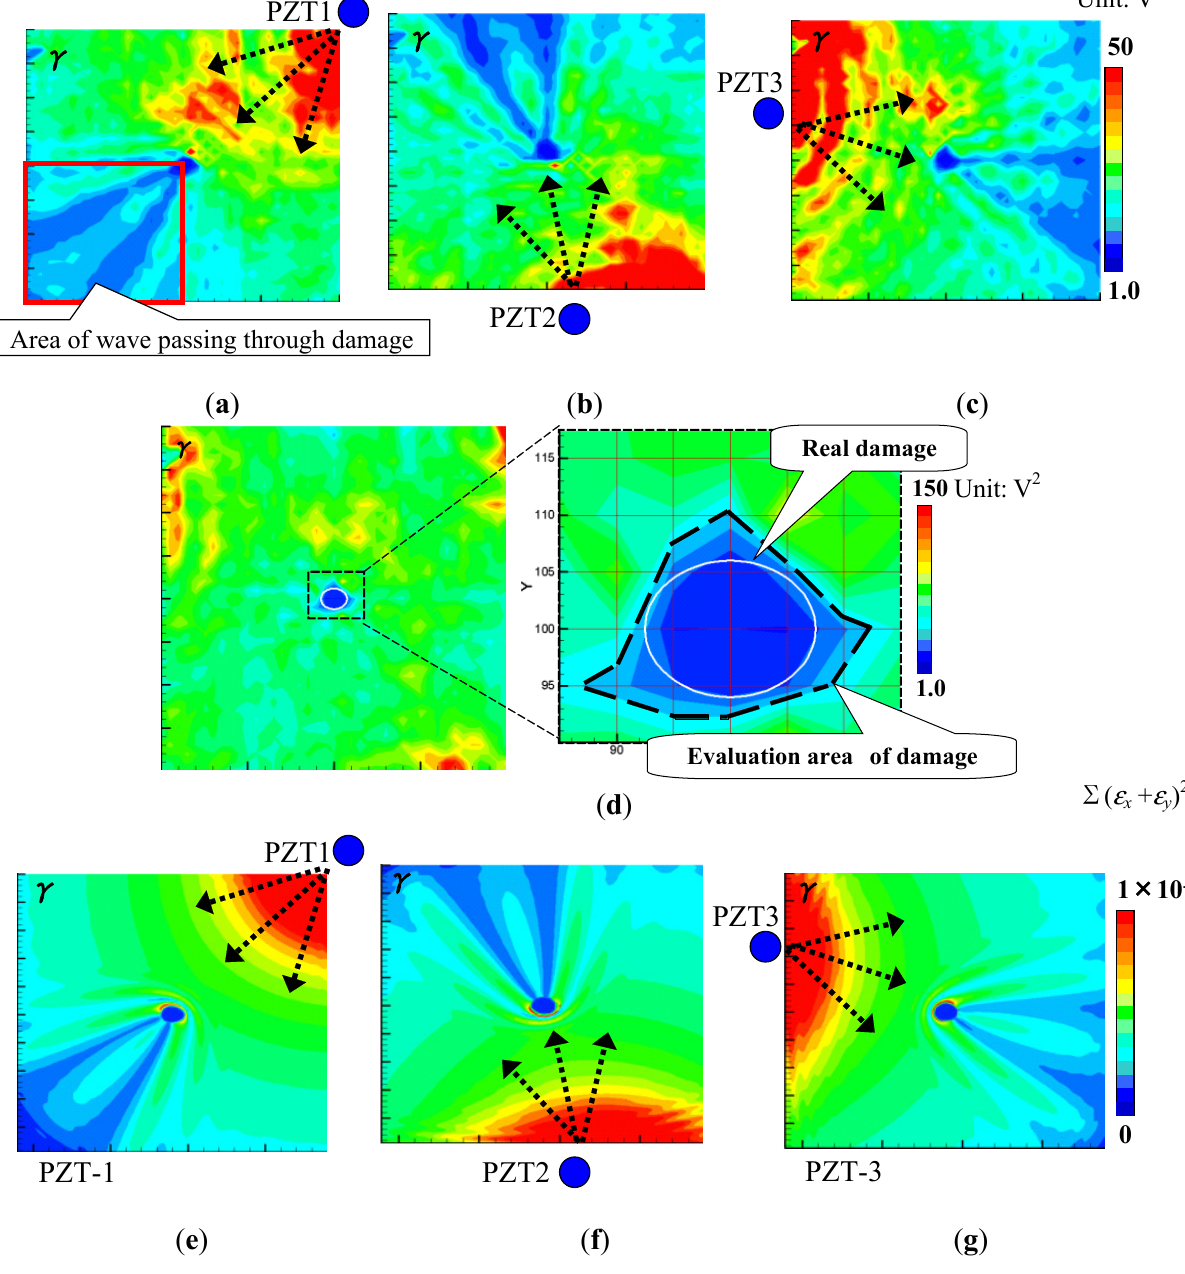
Figure 4. Images of γ distribution using the present WEF map technique for the aluminum plate with an elliptical through-hole: ( a ) experimental result of PZT-1; ( b ) experimental result of PZT-2; ( c ) experimental result of PZT-3; ( d ) experimental result of PZT-(1 + 2 +